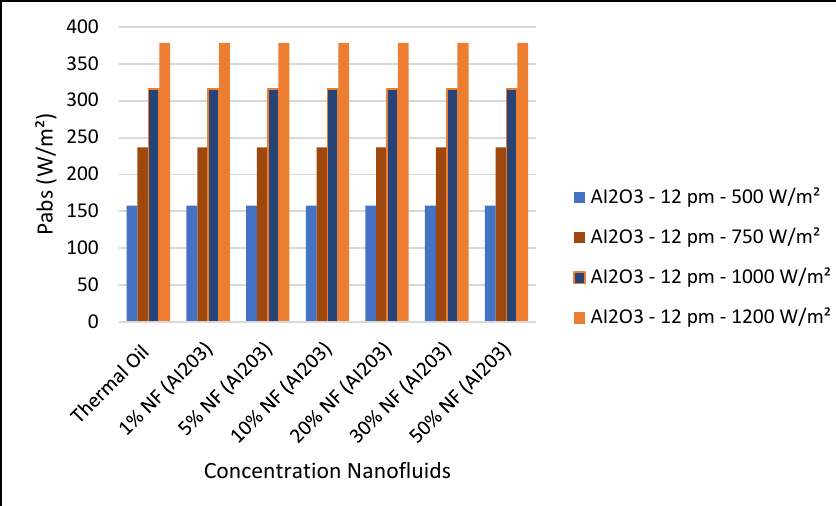
Figure 18. ORC refrigerant flow rate at 20% concentration of Al 2 O 3 at different times.